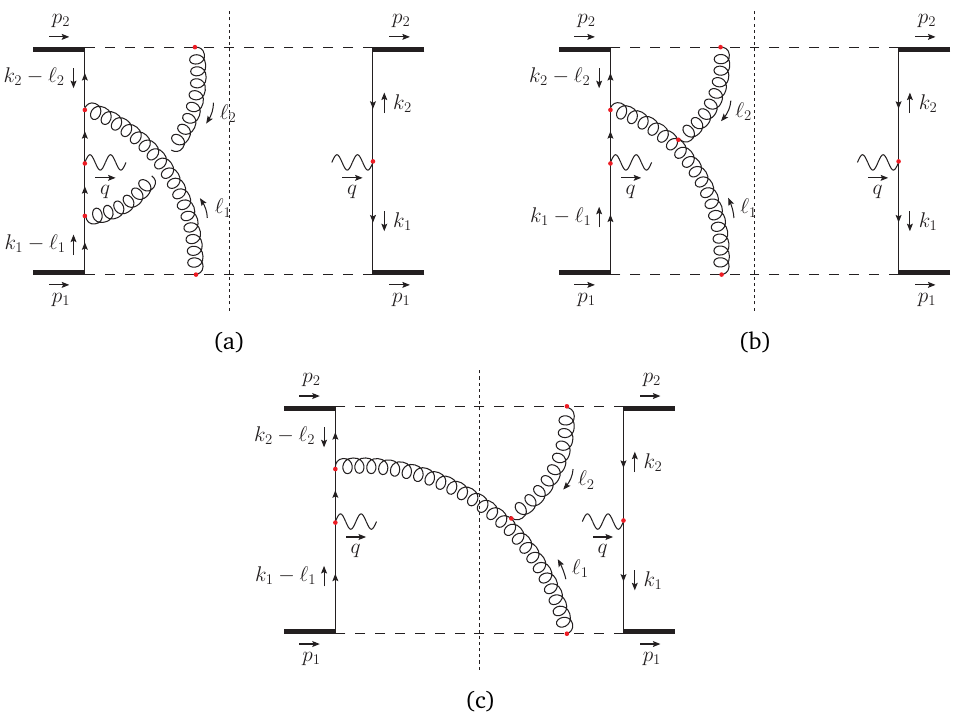
Figure 9: The relevant double-gluon exchange graphs that contribute to the dBM part of the DY cross section. This set is supplemented by graphs that can be obtained by p ↔ ¯ p or Hermitian